Question: According to the figure, is the described quantity increasing or decreasing?
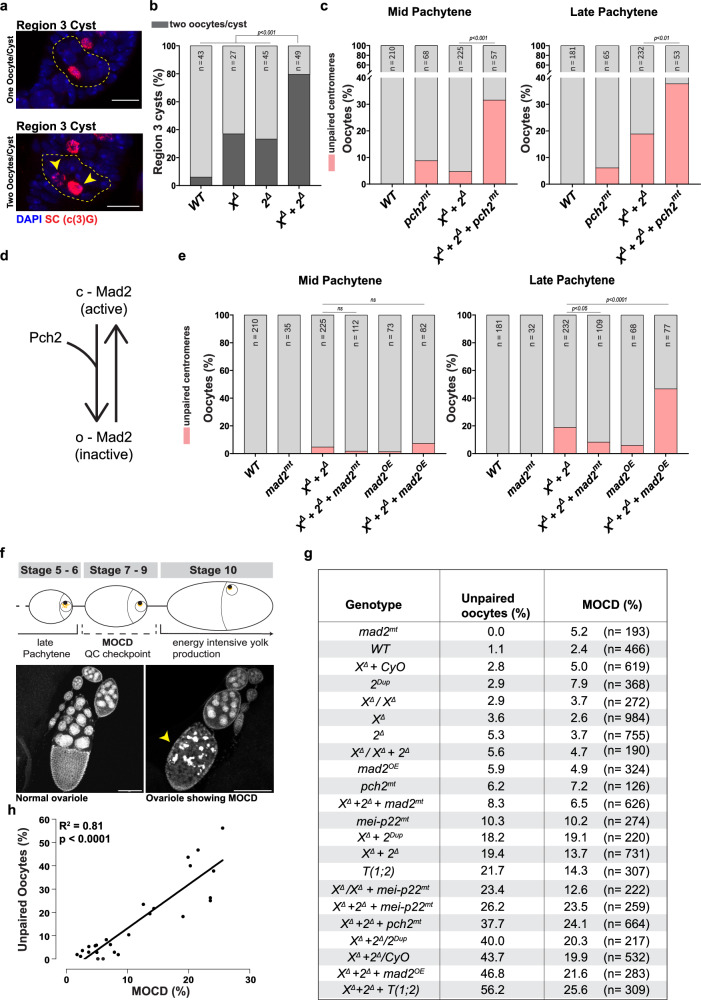
Answer: increasing